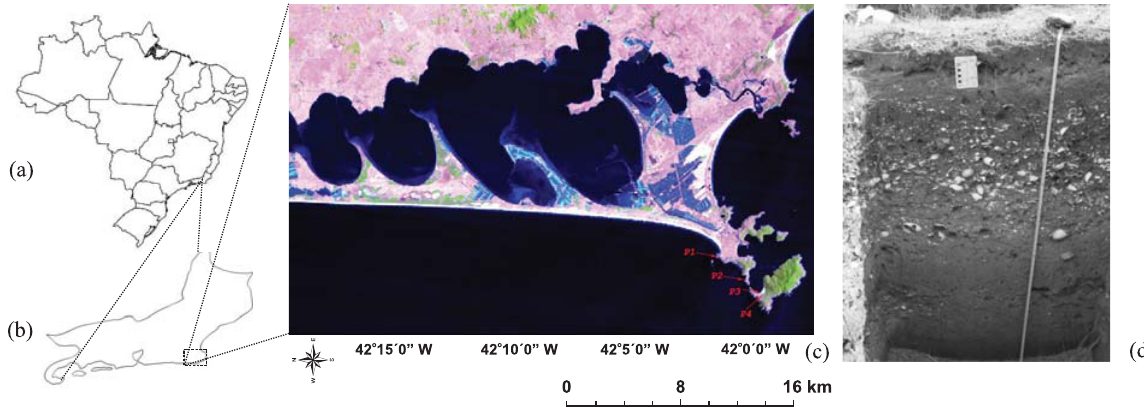
Figure 1. Location of the study area (a, b, c); image of one of the studied profiles (P4)